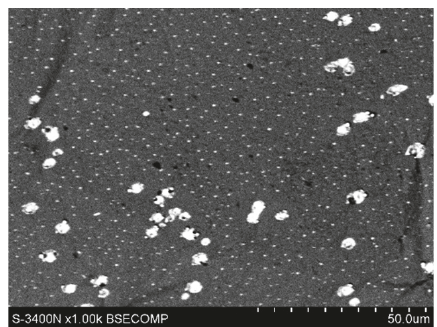
Figure 8: SEM micrograph of Pb 1.2/air sample: differences in size of Pb precipitates are visible.